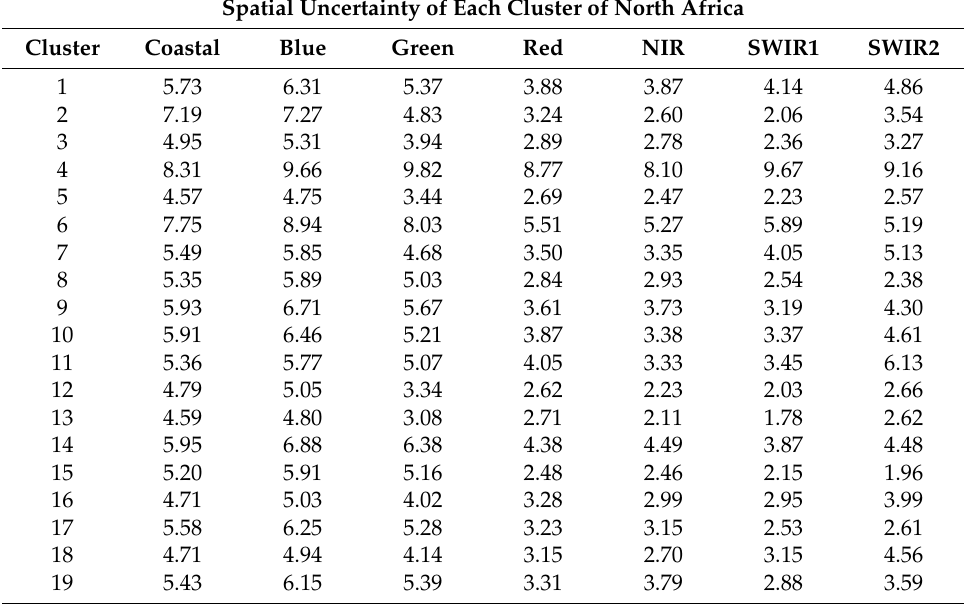
Table 2. Cluster Spatial Uncertainties, by Band.